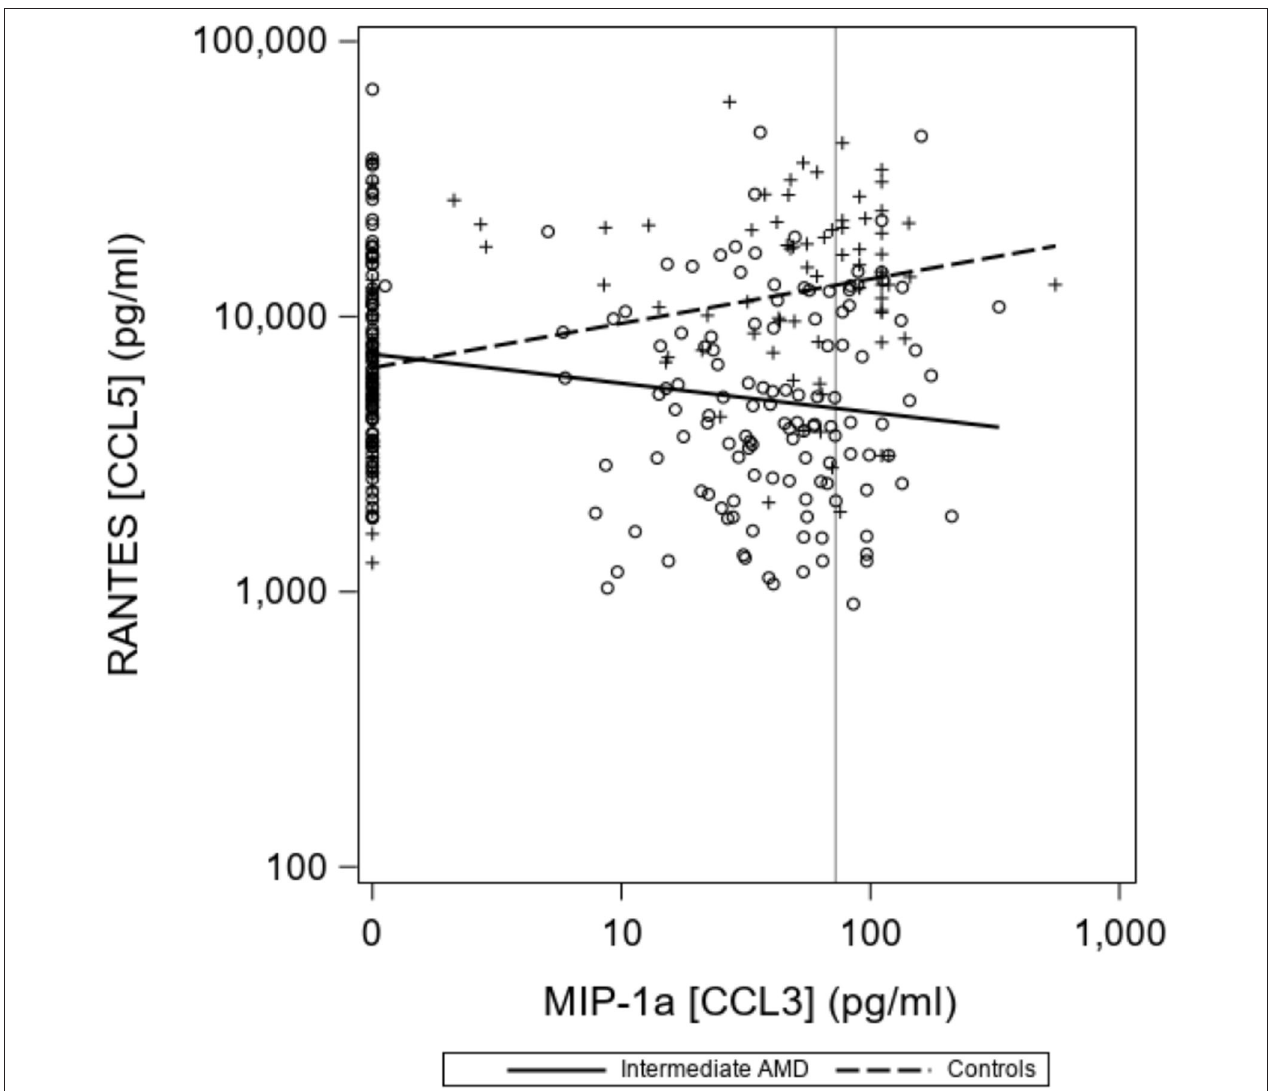
FIGURE 2 | Correlations between chemokines CCL3 and CCL5 differ in controls and iAMD. The vertical line corresponds to the lower limit of detection (LLOD) for CCL3. Spearman Coefficient (95%CI) = − 0.20 ( − 0.33, − 0.07) in iAMD and = 0.37 (0.19, 0.53) for controls.